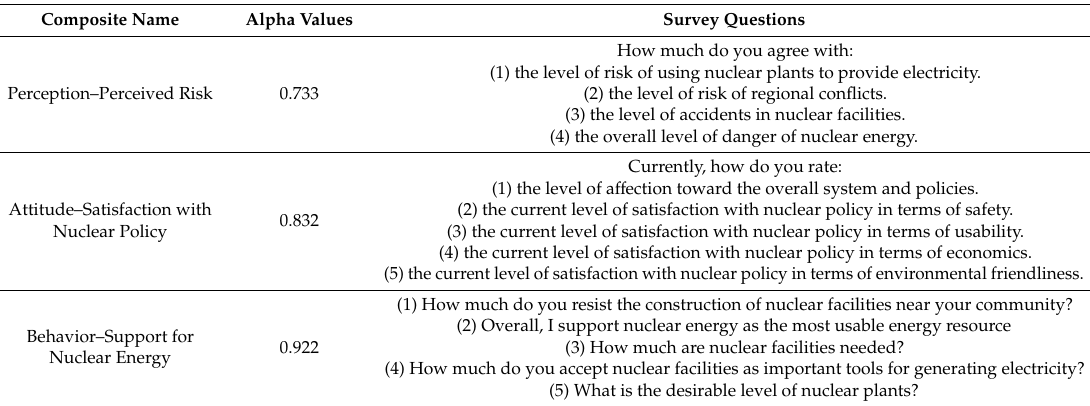
Table 2. Measures and reliability test.